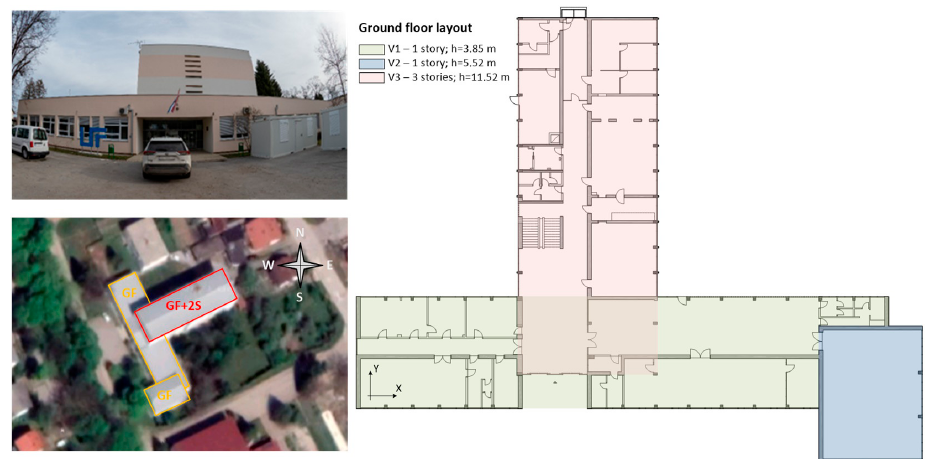
Figure 3. Case study building.